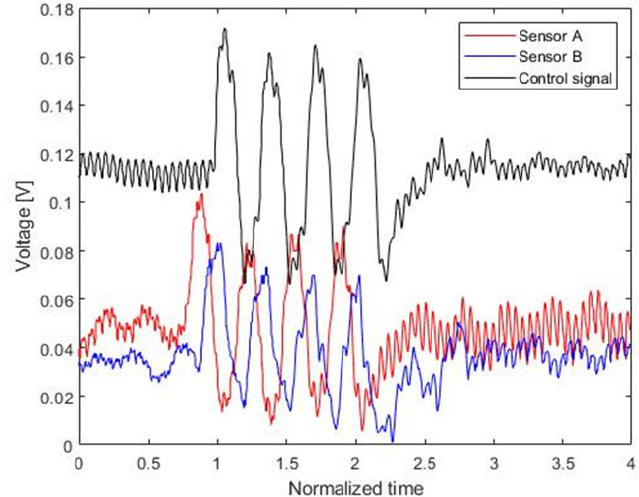
Figure 11. Control signal and PVDF signal.